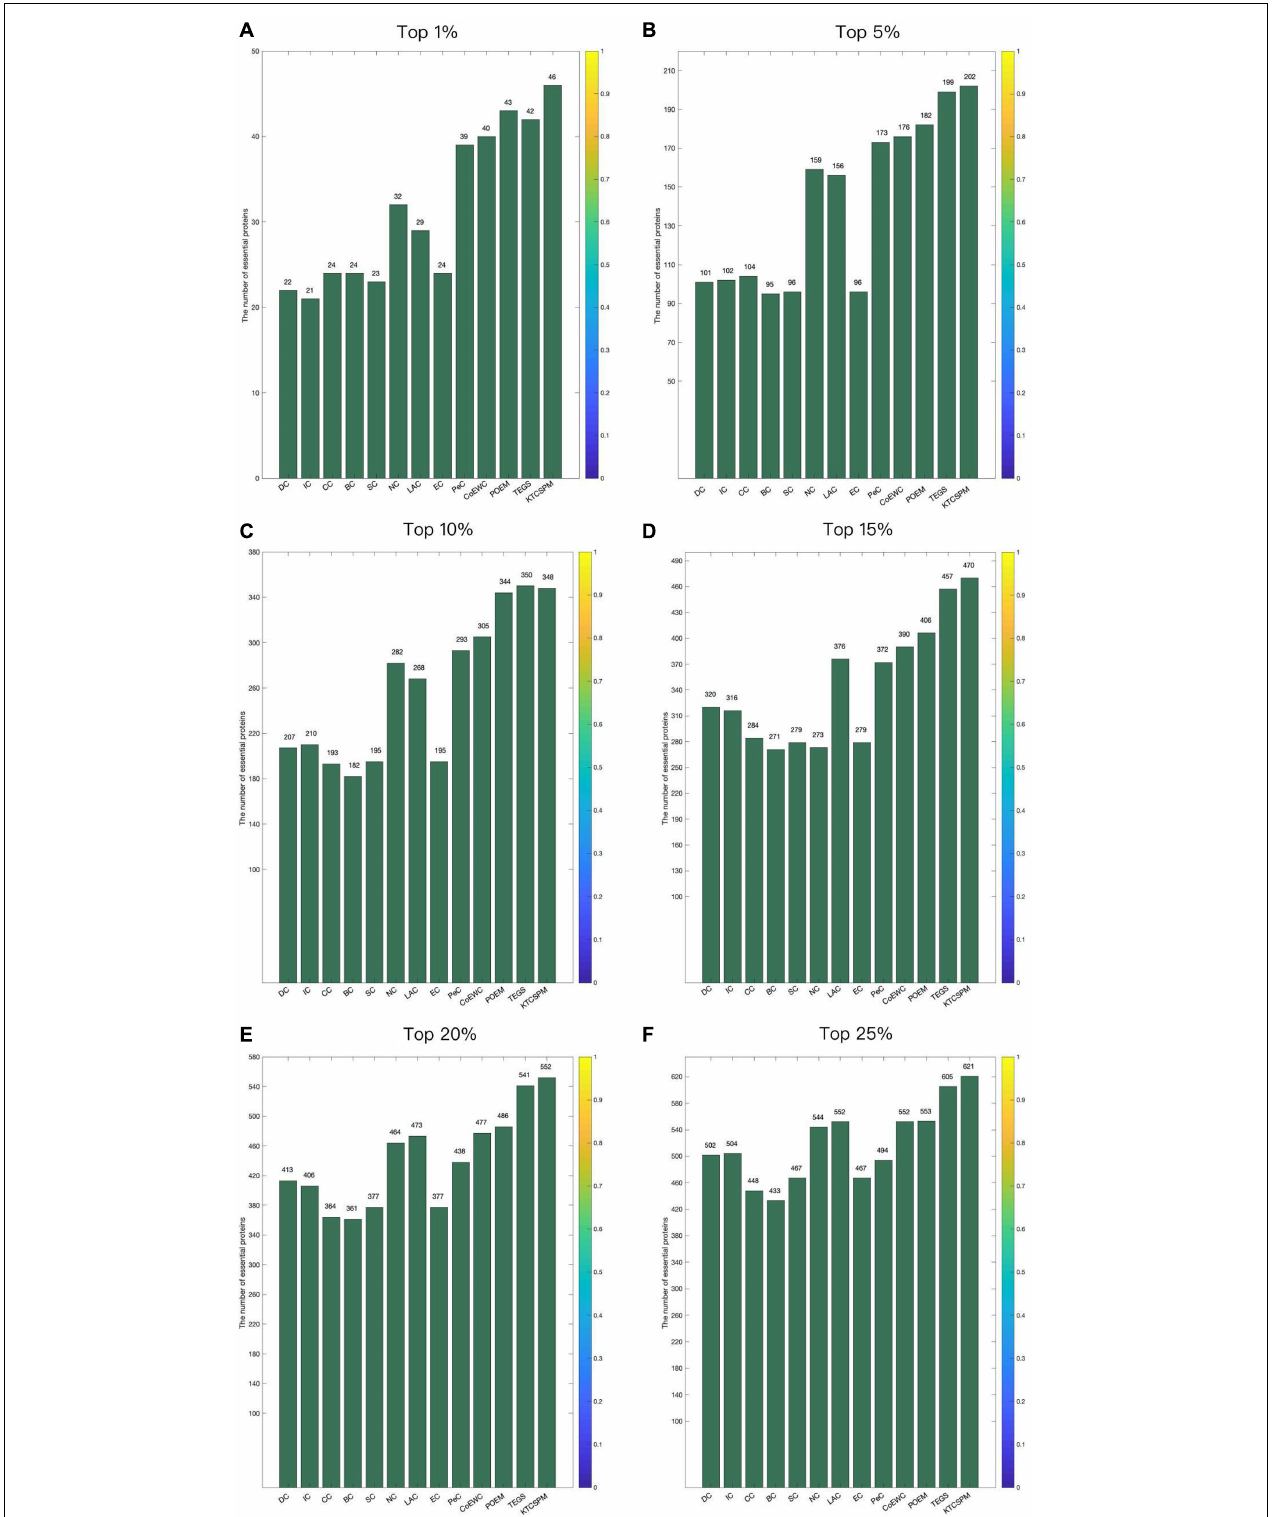
FIGURE 3 | (A) Top 1% ranked proteins. (B) Top 5% ranked proteins. (C) Top 10% ranked proteins. (D) Top 15% ranked proteins. (E) Top 20% ranked proteins. (F) Top 25% ranked proteins. In this Figure shows the predictive accuracy between KTCSPM and 12 competitive methods including IC, CC, BC, SC, NC, LAC, EC, PeC, CoEWC, POEM, and